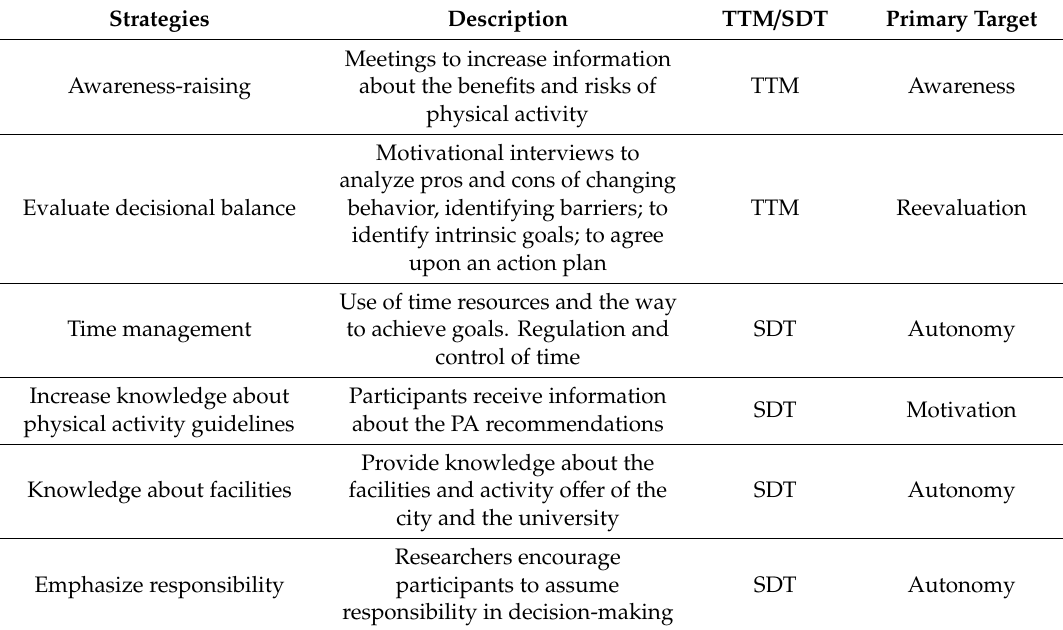
Table 1. Intervention program strategies. Cognitive phase. Self-determination theory (SDT), transtheoretical model